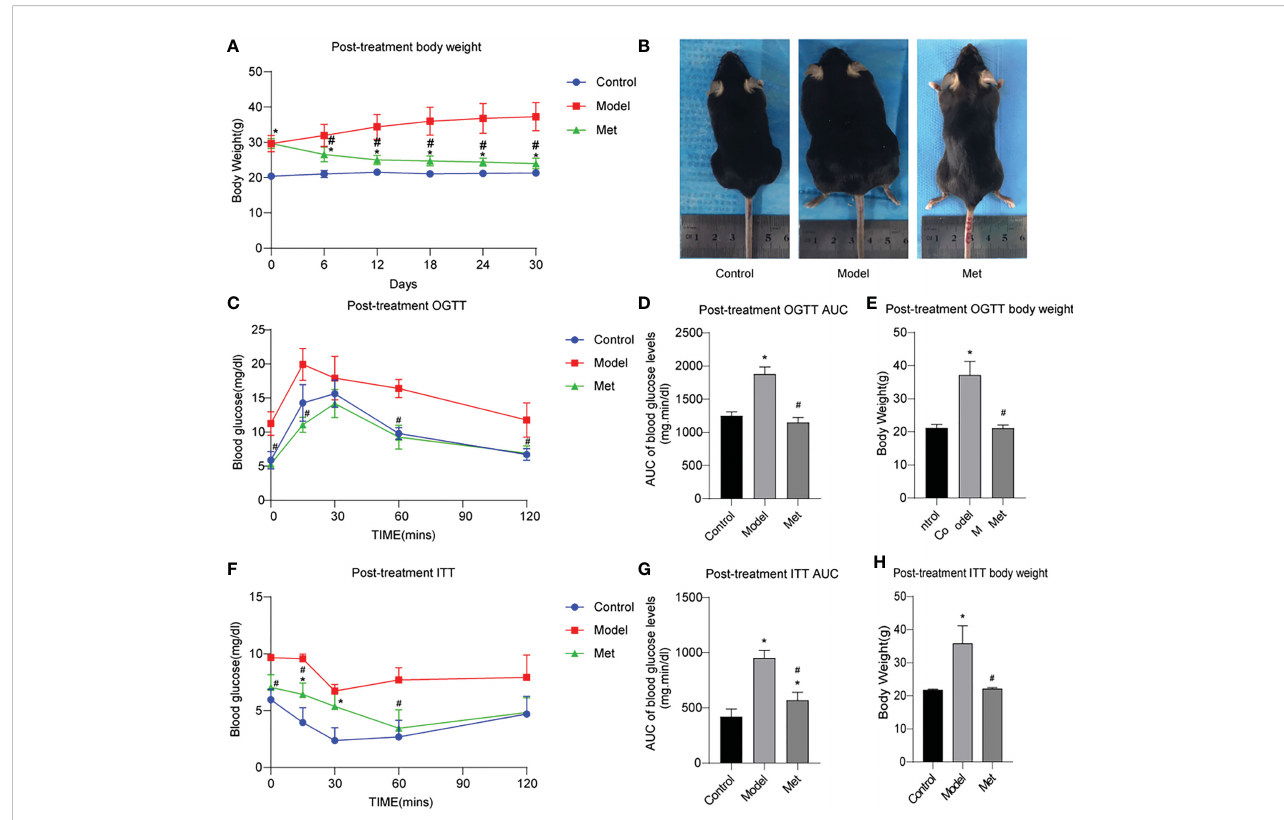
FIGURE 1 Metformin improves obesity, impaired glucose tolerance and insulin resistance in PCOS mice. (A) Body weight change of three groups of mice after treatment; (B) Body size of three groups of mice after treatment; (C) OGTT of three groups of mice after treatment; (D) Area under the OGTT curve (AUC) of the three groups of mice after treatment; (E) Body weight of the three groups of mice after treatment during OGTT measurement; (F) ITT of the three groups of mice after treatment; (G) Under the ITT curve of the three groups of mice after treatment Area (AUC); (H) The body weight of the three groups of mice at ITT was measured after treatment. *P < 0.05 vs control group; #P < 0.05 vs PCOS group. Mean = SEM, n =